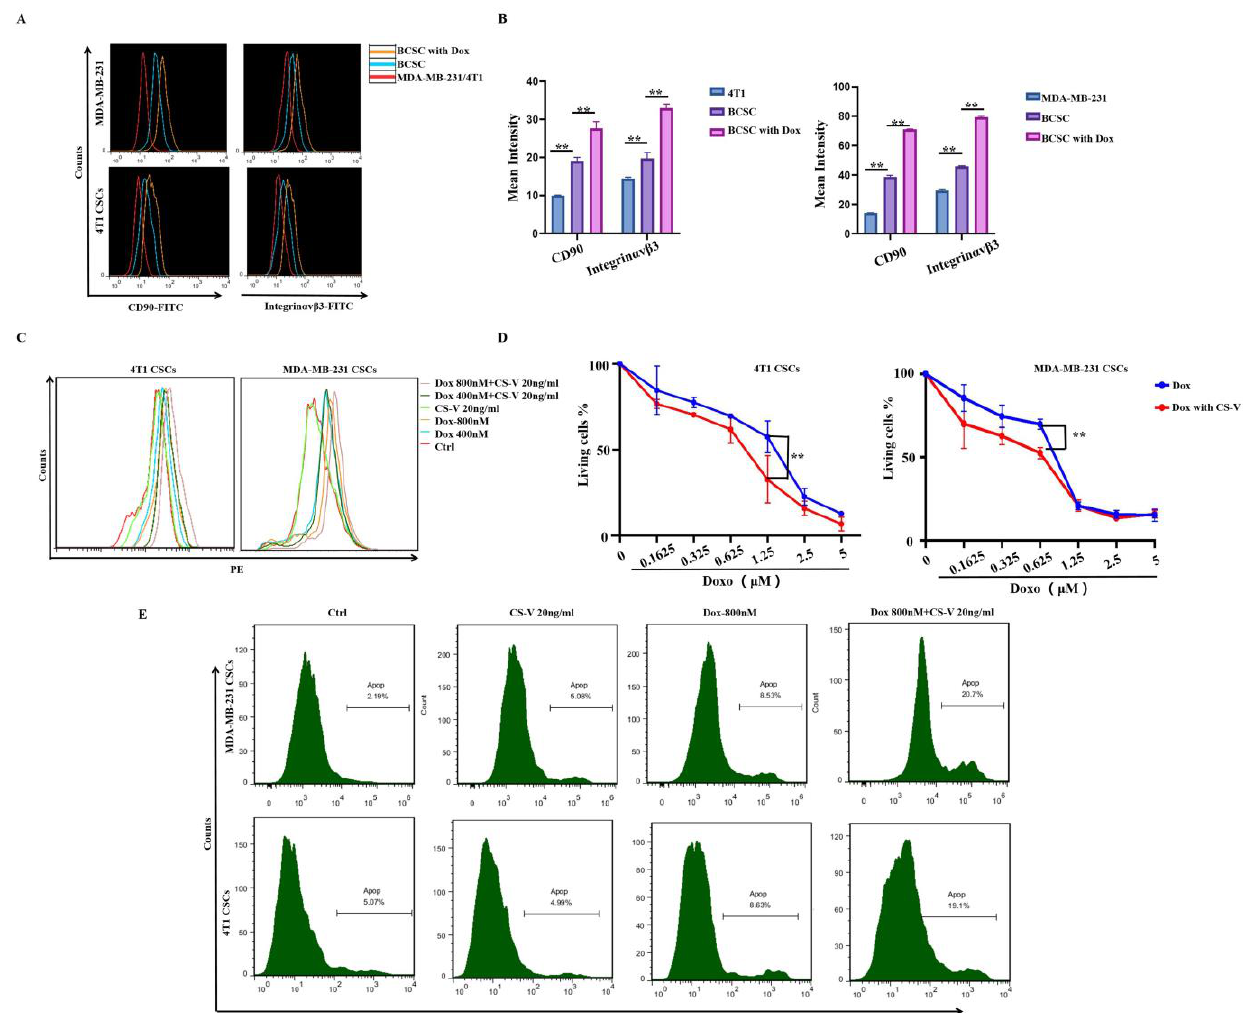
Figure 3. CS-V nanoparticles enhanced the activity of doxorubicin against BCSCs. ( A ) Flow cytometry results of the surface marker CD90 and integrin α v β 3 expression induced by doxorubicin in BCSCs derived from MDA-MB-231 and 4T1 cells. ( B ) Statistical analysis of CD90 and integrin α v β 3 expression induced by doxorubicin in BCSCs derived from MDA-MB-231 and 4T1 cells. ( C ) Flow cytometry analysis revealed that doxorubicin uptake was increased by CS-V nanoparticles. ( D ) Anti-proliferation activity of doxorubicin against BCSCs was enhanced by CS-V nanoparticles. ( E ) AnnexinV-FITC staining detected by flow cytometry revealed that apoptotic death induced by doxorubicin in BCSCs was enhanced by CS-V nanoparticles. (** p < 0.01, n = 3 biologically independent samples per group).